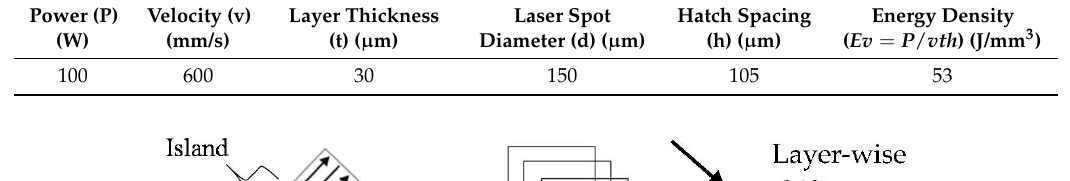
Figure 2. ( a ) island hatch strategy [22] and ( b ) island shift strategy.